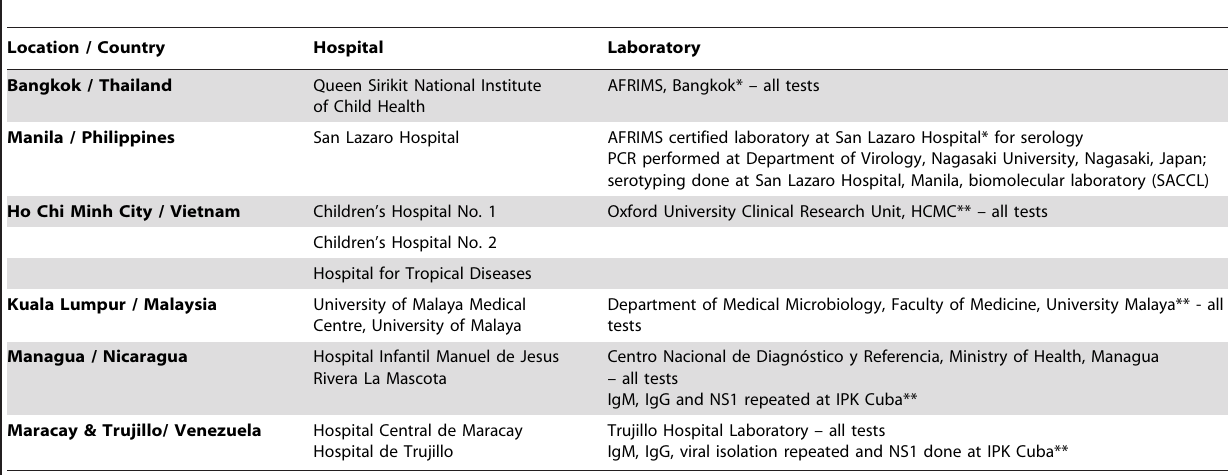
Table 1. List of laboratories performing diagnostic testing for the patients enrolled in the DENCO study.